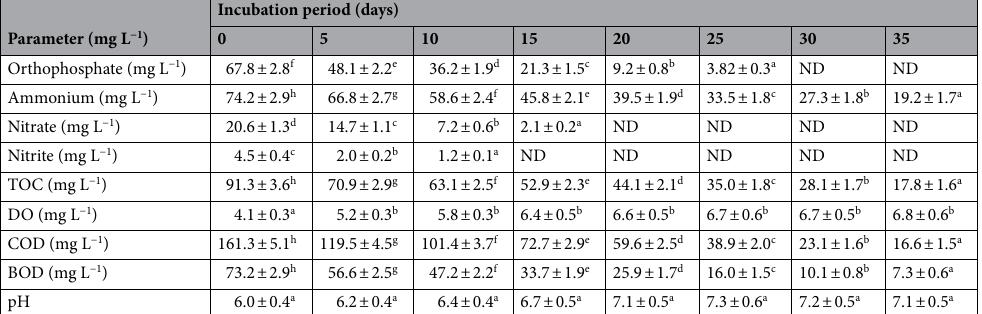
Table 6. Concentration changes in APL medium after inoculation with A. variabilis . Values were calculated as the mean (± SE) of three independent observations, i.e., n = 3. ND = Not detected. Significant differences among the values (P < 0.05, DMRT) within a row are designated using different alphabetic annotations.